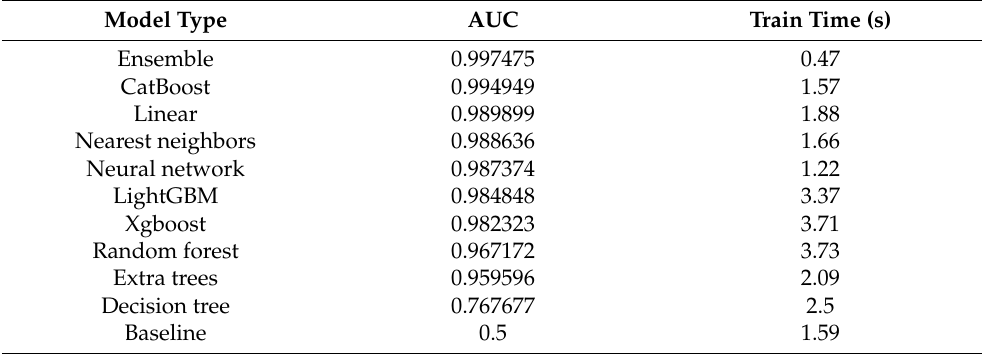
Table 2. Area under the receiving operator characteristics curves (AUC) of different algorithms from the autoML pipeline on the training set.